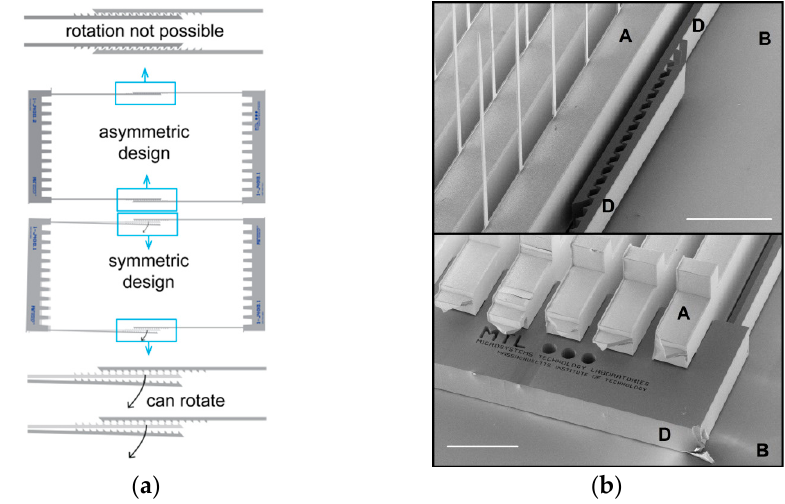
Figure 5. ( a ) Different locking designs for the self-alignment combs. For narrow distances, the symmetric design is acceptable but as the two combs are spaced further apart, rotations can cause problems and an asymmetric design instead is preferred. ( b ) The SEM on the right shows detailed views of the tapered comb (D) locked between the 2-D inserts (A) and holder plate (B) in the bottom image and its beams (D) locked onto itself in the top image. The scale bar is 1 mm.